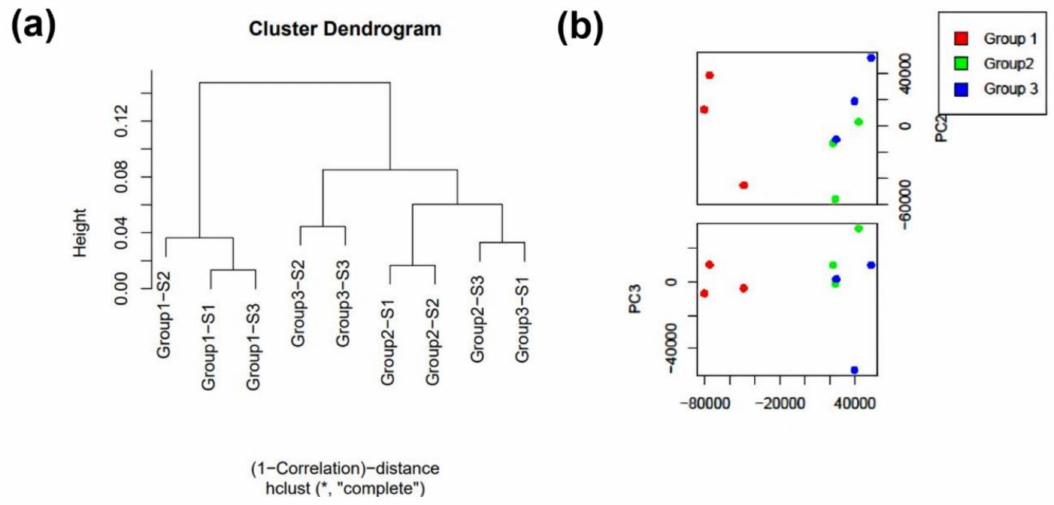
Figure 6. ( a ) miRNA-seq data analysis: cluster dendrogram for the miRNA data. ( b ) PCA (group 1—cells, group 2—EVs, and group 3—EV proteinase K and RNase